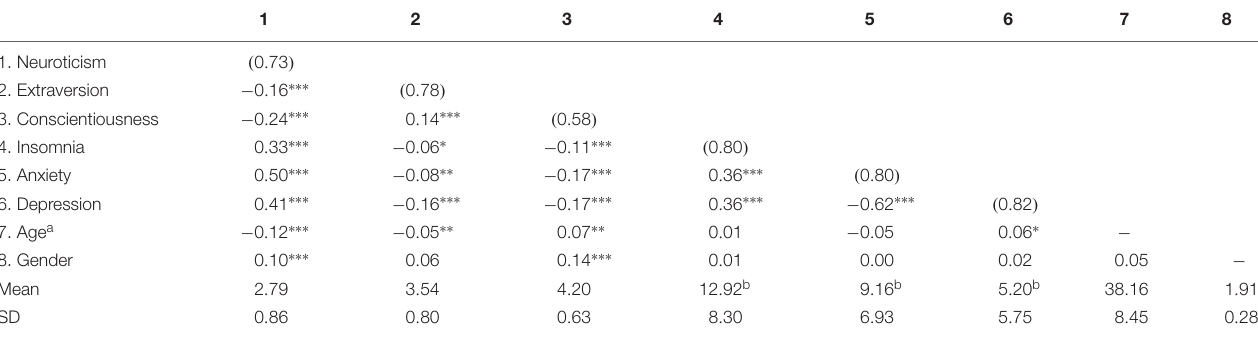
TABLE 1 | Means, standard deviations, Raykov’s reliability coefficients, and Pearson correlation coefficients for all continuous variables ( N = 1506–1516).